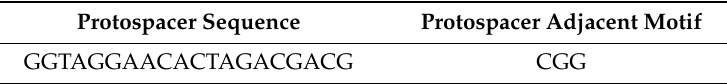
Table A1. CRISPR-Cas9 Target sequence used for STL1 deletion.